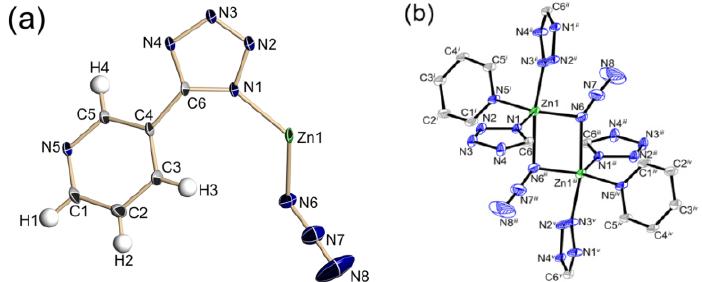
Figure 2. The two zigzag chains linked by azido ligands are vertical to each other, and a novel 2D Figure 3. ( a ) Thermal ellipsoid plots of the asymmetric unit of compound with the 50% probability rectangulargrid-like layer parallel to the ab -plane of unit cell is formed[37]. level, whereas hydrogen atoms are drawn as spheres of arbitrary radii. ( b ) Thermal ellipsoid plot of symmetrical molecular arrangement. Hydrogen is omitted for clarity[41].